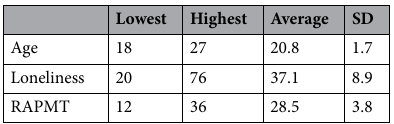
Table 1. Descriptive statistics. SD: standard